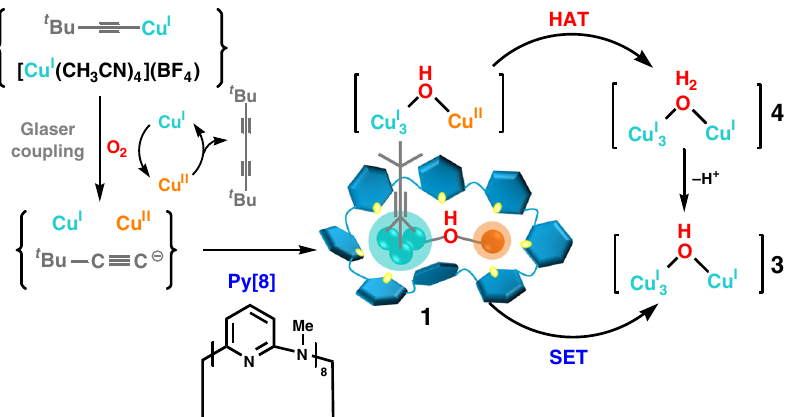
Fig. 1 Synthesis and transformations of complex 1 . Synthesis and transformations of the Py[8] -protected mixed-valence cluster [( t BuC ≡ CCu I 3 )-( μ 2 -OH)- Cu II ] in 1